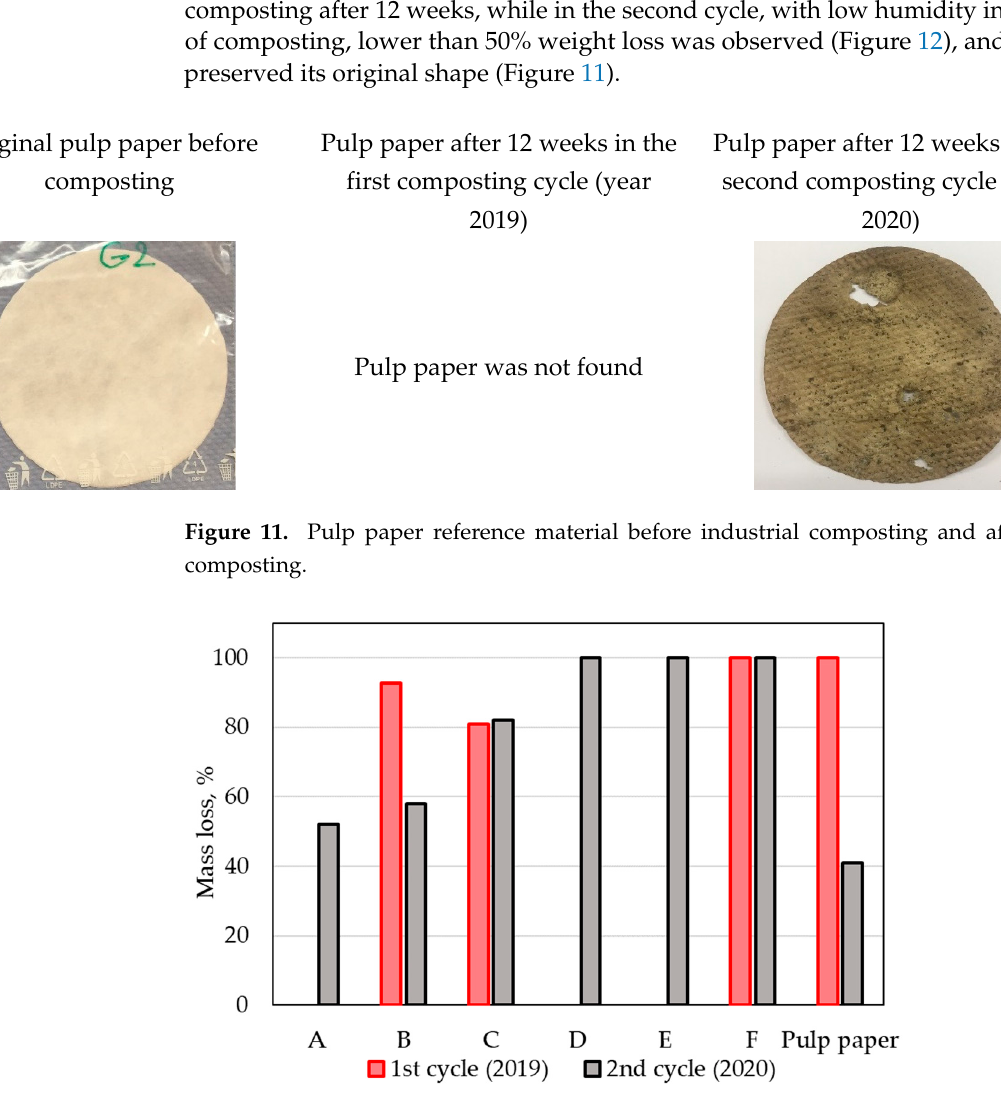
Figure 12. Weight losses of the tested samples after 12 weeks of incubation in the first and second composting cycles at a municipal composting plant.